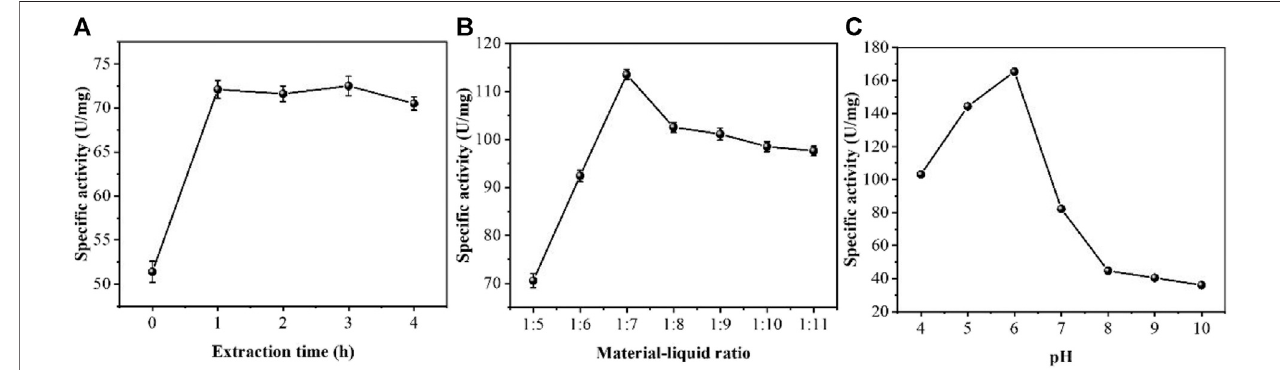
FIGURE 1 | Effect of (A) extraction time (B) material-liquid ratio and (C) pH on enzyme speci fi c activity of Erycibe